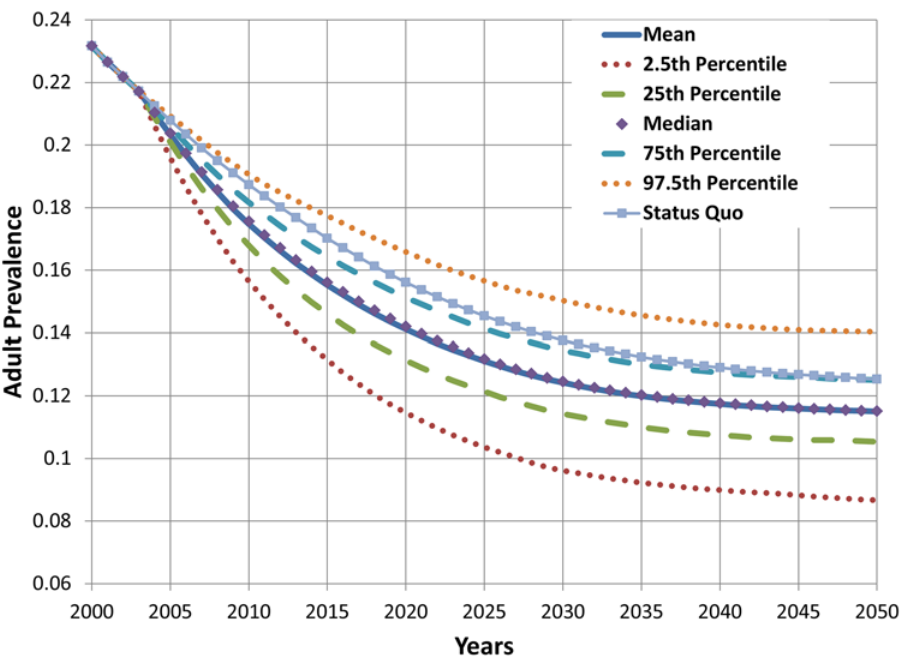
Fig 12. Projected adult prevalence of cigarette smoking from multivariate uncertainty analysis, 2000 –